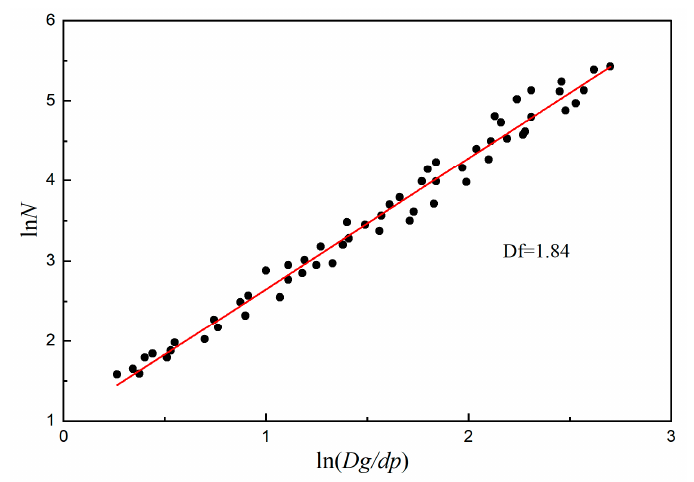
Figure 3. Statistical determination of soot aggregate fractal dimension (Df) for the GDI PM. Table 1. Summary of the morphological features of GDI particles in previous studies.